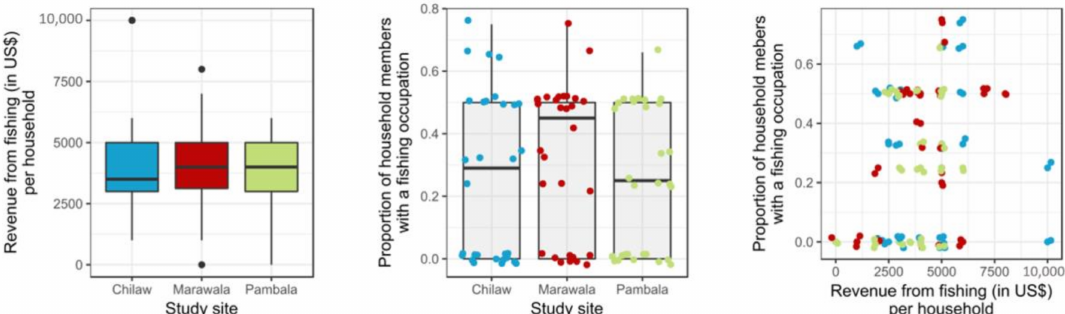
Figure 5. Mean household revenue from fishing related occupations ( left ) mean proportion of household members with fishing related occupations ( middle ). The relationship between the proportion of household members following a fishing related occupation and the household revenue from these fishing related occupations ( right ). Points are coloured according to the study sites.